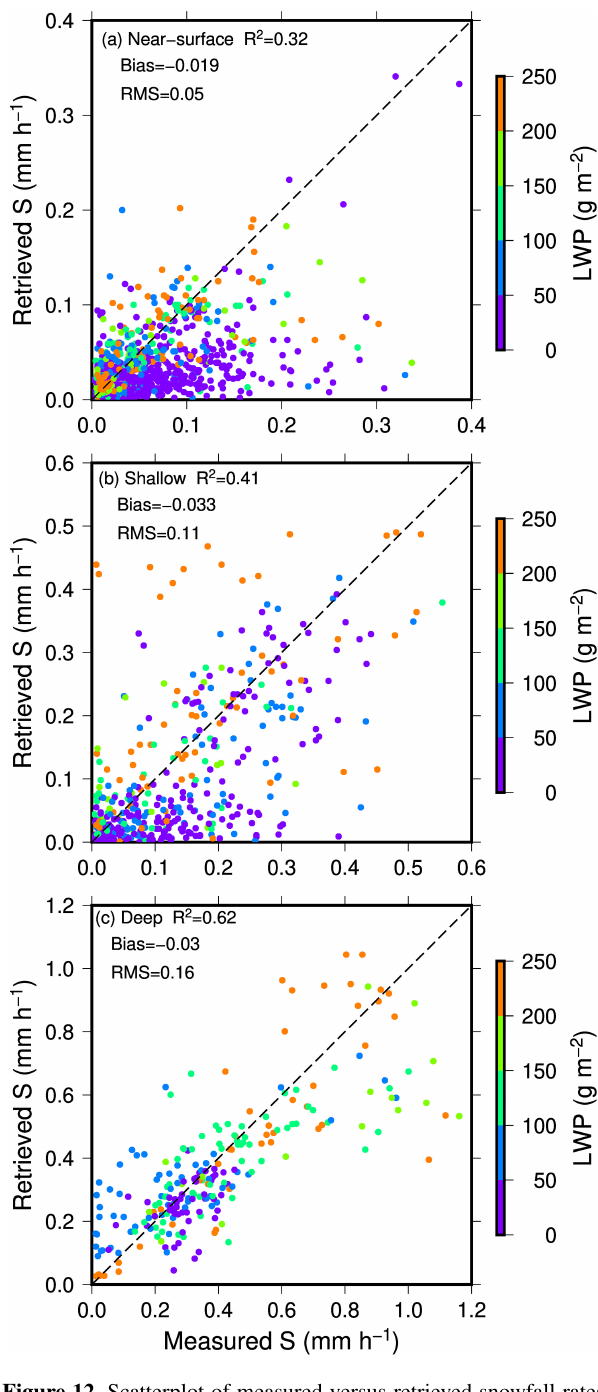
Figure 12. Scatterplot of measured versus retrieved snowfall rates for (a) near-surface, (b) shallow, and (c) deep snow clouds over land. The color of the points indicates the liquid water path asso- ciated with the case. The correlation is indicated by R 2 in each diagram. Biases and root mean square (RMS) differences are also indicated in the